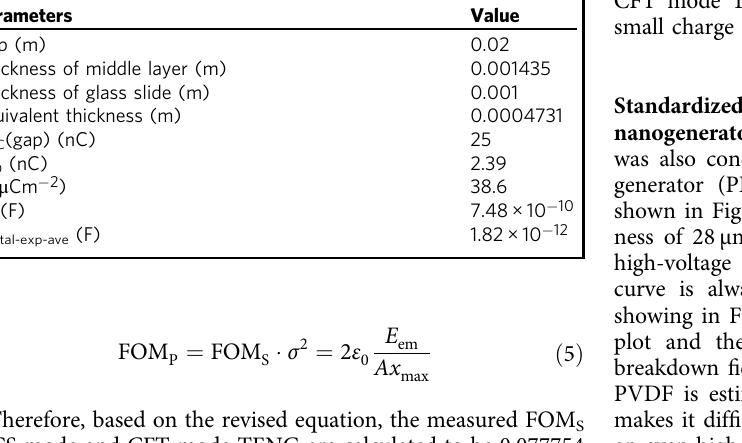
and 2.40115, respectively, as shown in Supplementary Note 1